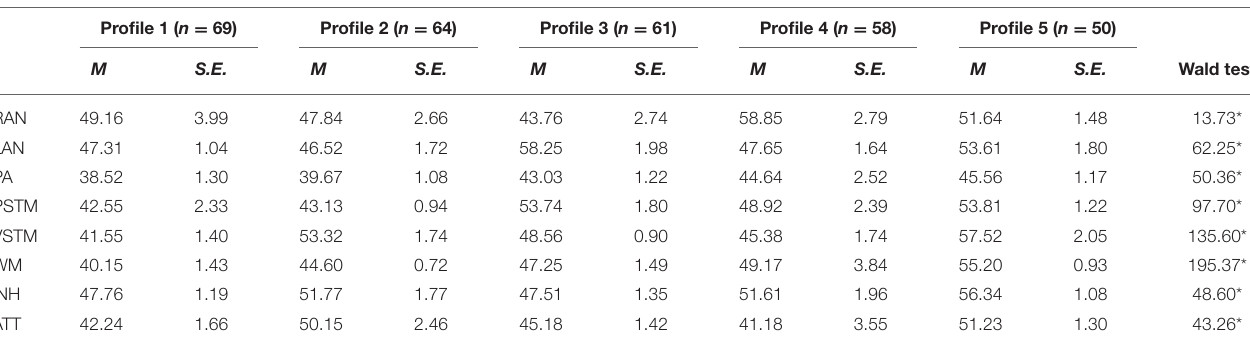
TABLE 4 | T -scores of the cognitive functioning scales for the five-profile solution. Profile 1 ( n = 69) Profile 2 ( n = 64) Profile 3 ( n = 61) Profile 4 ( n = 58) Profile 5 ( n =